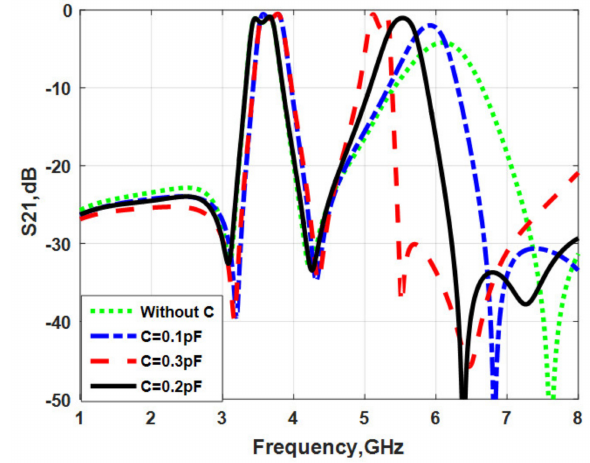
Figure 16. S 21 of the BPF filter with various values of lumped capacitors.